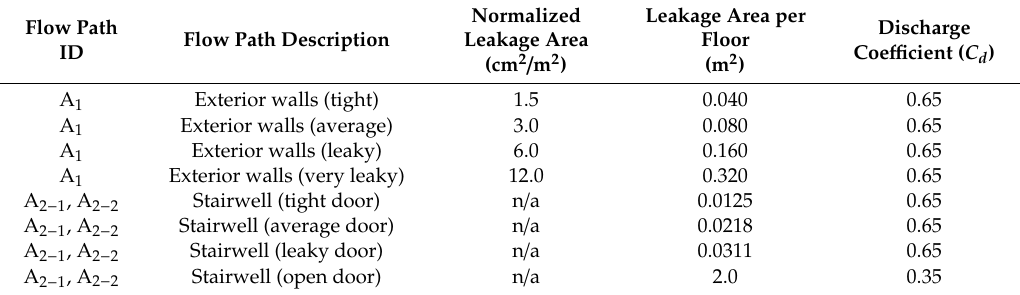
Table 3. Idealized building component parameters.